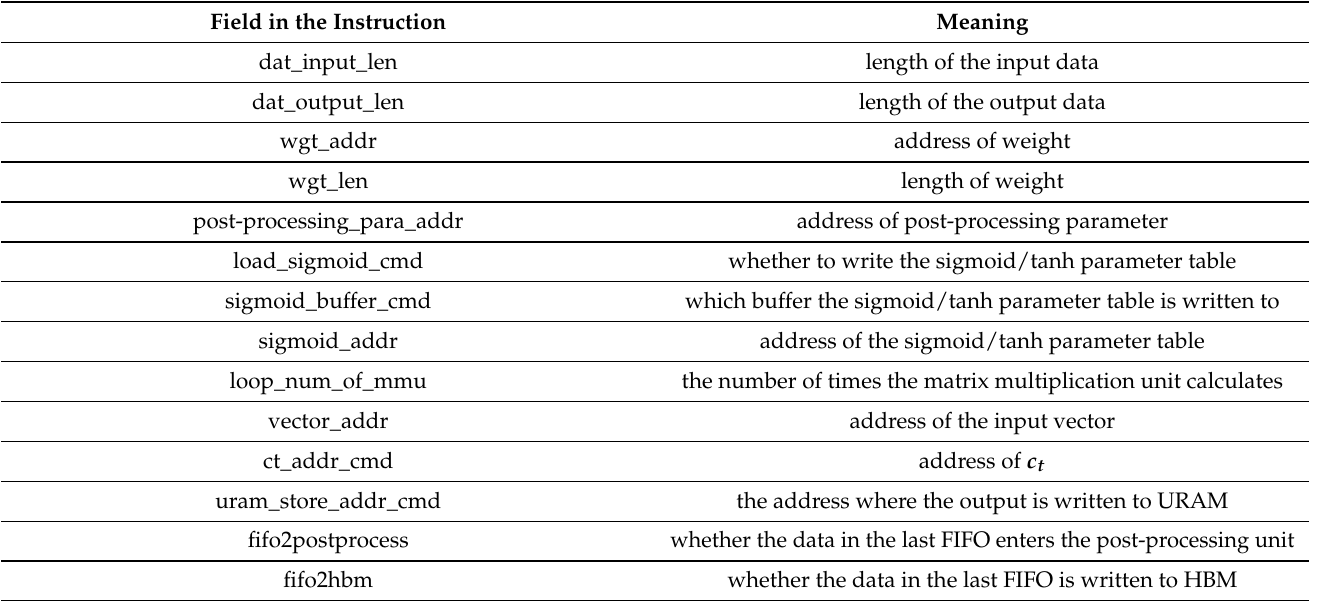
Table 2. Details in one